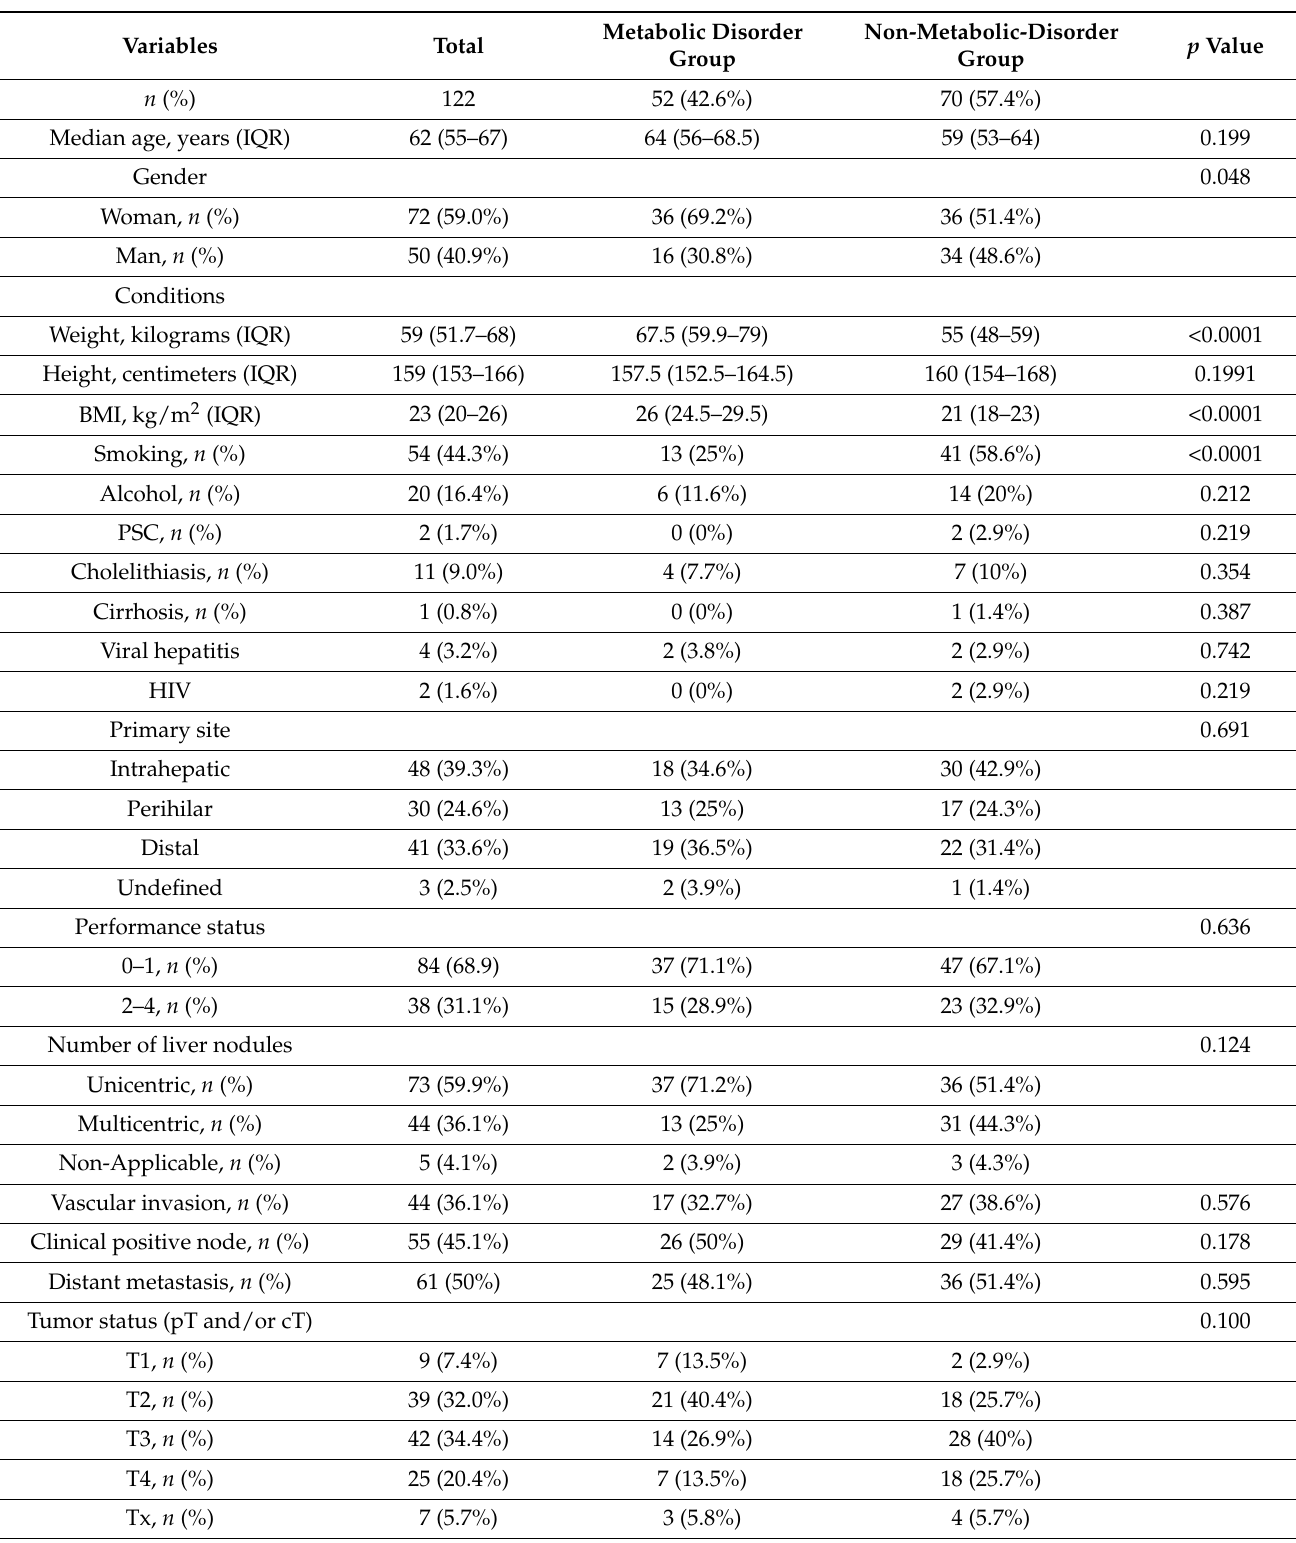
Table 1. Baseline features of the total cohort and subgroups according to the coexistence of metabolic